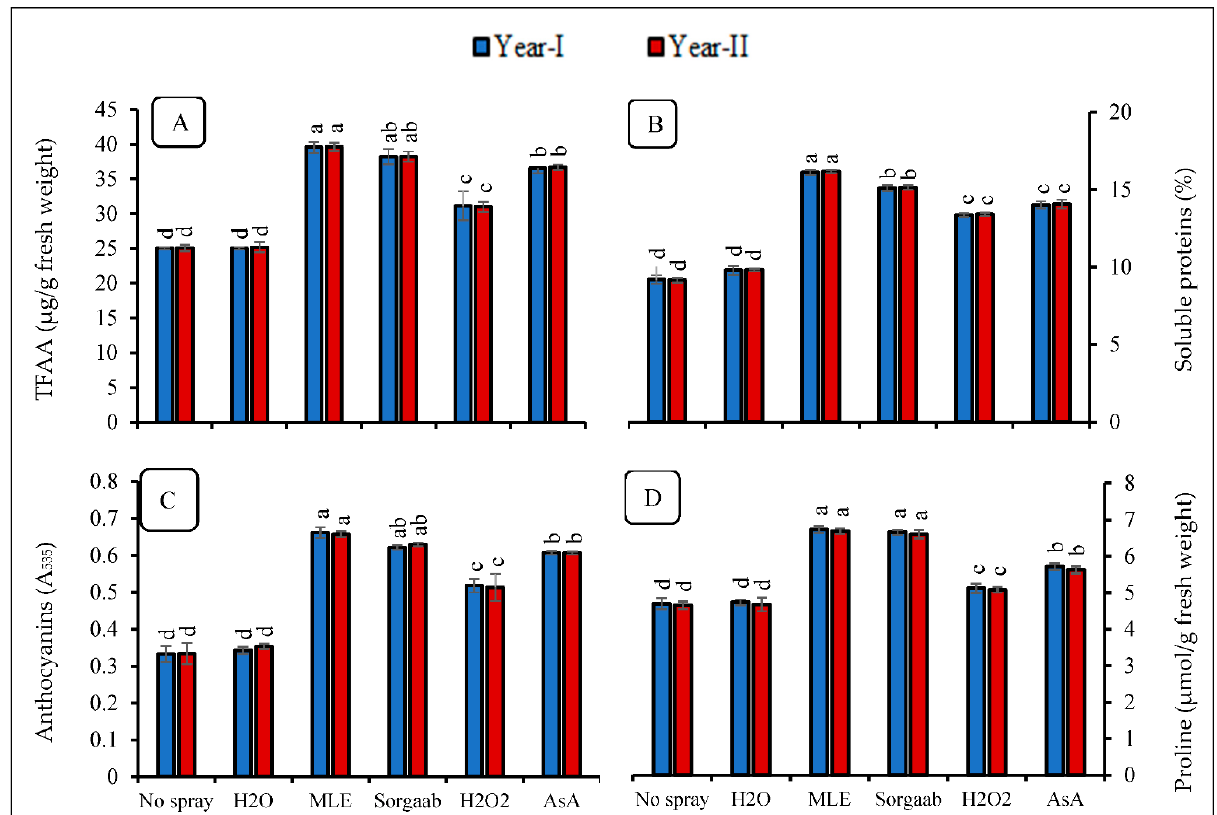
Figure 3. Influence of plant growth promoters on total free amino acid (A), total soluble proteins (B), anthocyanin (C) and proline (D) of quinoa cultivated during the growing seasons of 2016–2017 and 2017–2018. Bars sharing the same letter did not differ significantly at P = 0.05.